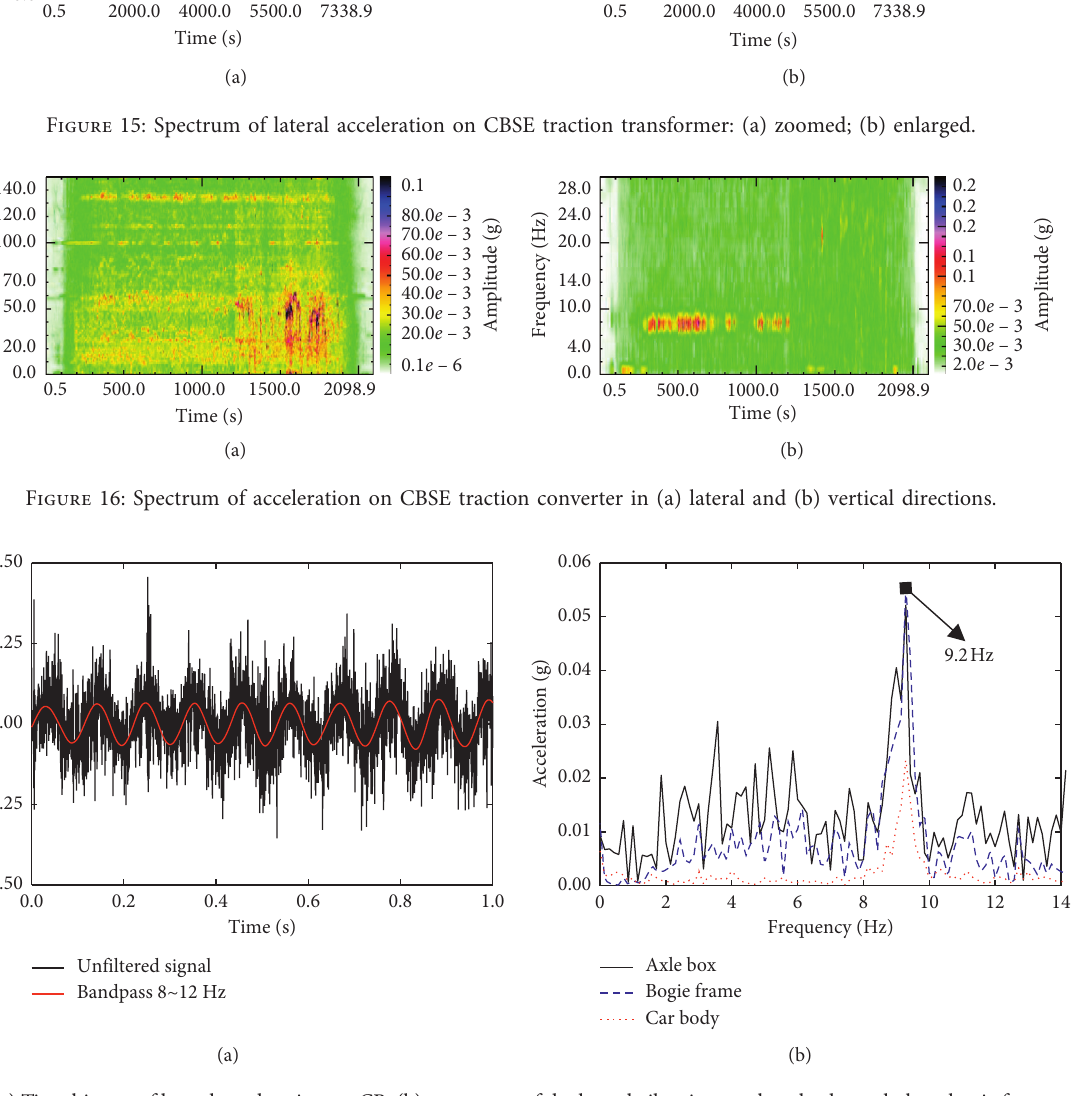
Figure 17: (a) Time history of lateral acceleration on CB; (b) spectrums of the lateral vibration on the wheelset axle-box, bogie frame, and